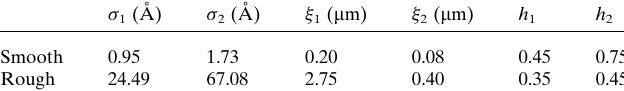
Table 1 Fitting parameters to PSD data for the smooth and rough samples.